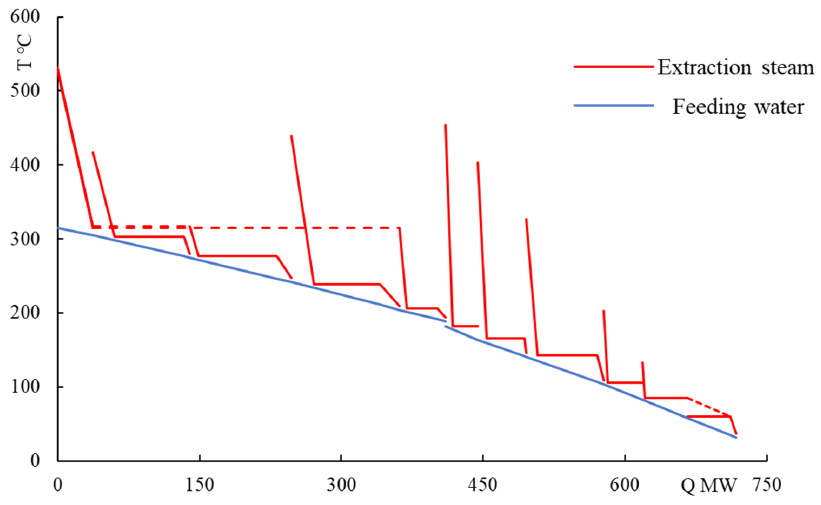
Figure 3. Heat transfer process curve of the regenerative heating process. Generally, in the air preheater, the air temperature changes from 30 to 347 °C, and the feed water temperature changes from 30 to 314 °C. Their temperature change ranges are similar. The outlet temperature of the air is higher than that of the feed water, and the temperature difference between the air and the extraction steam is smaller. After heated by 9-, 10-stage steam extraction, the feed water temperature is about 80 °C. Comparing with the inlet air of the air preheater, the water heated by 9-, 10-stage steam extraction is more matched with the flue gas.